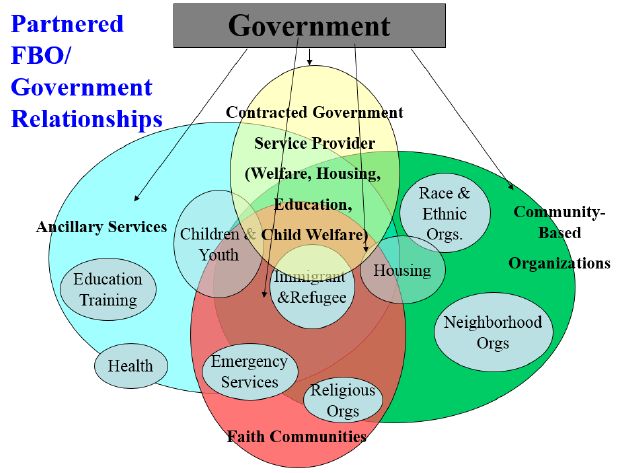
Figure 2. Partnered FBO/government relationships.